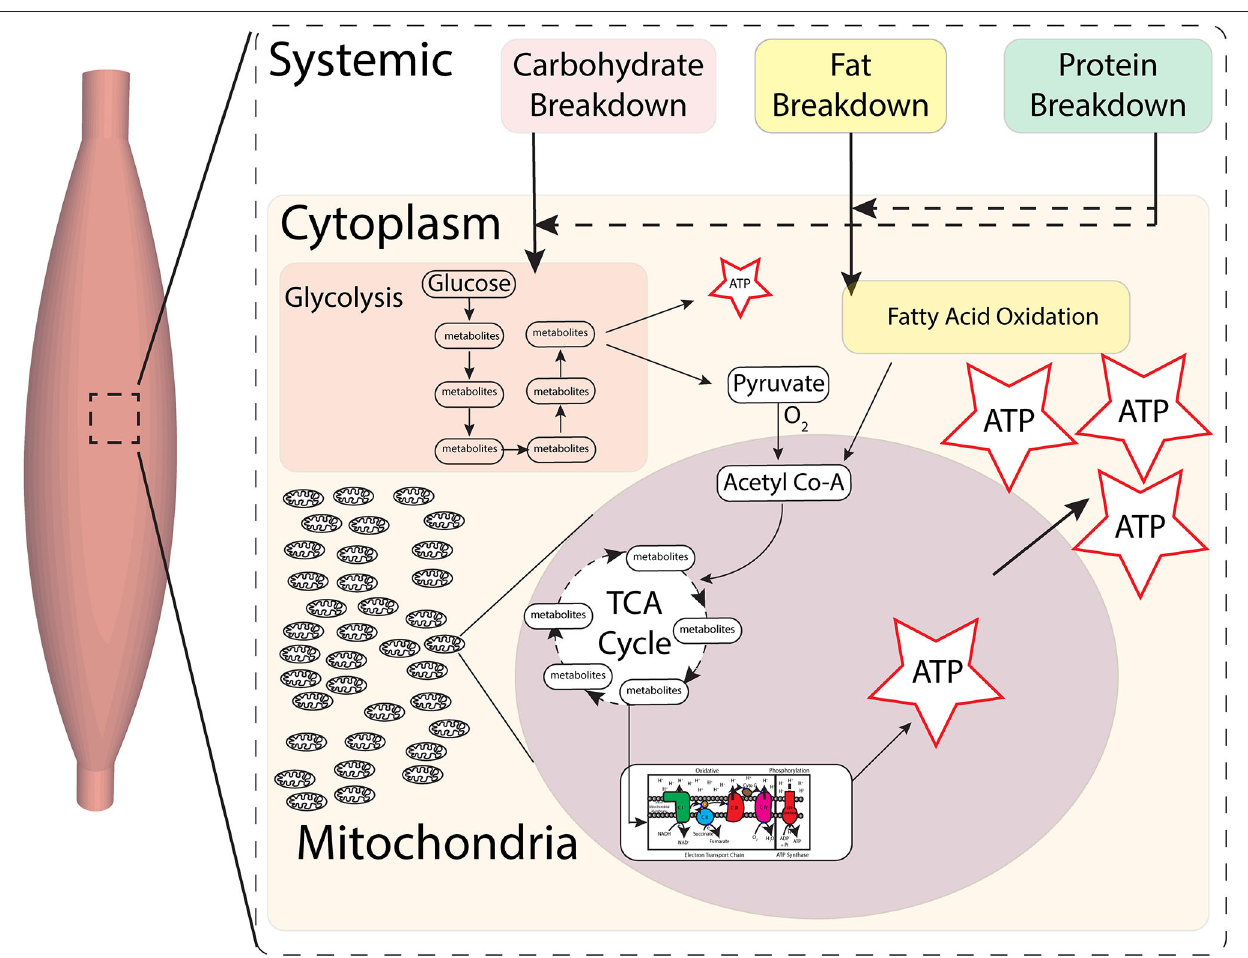
FIGURE 1 | Skeletal muscle metabolic pathways for energy. Carbohydrates, fats, and proteins foods are broken down systemically, substrates of which then enter cells. Production of energy by final breakdown of food occurs primarily within cells by glycolysis and fatty acid oxidation. Anaerobic glycolysis in the cytoplasm can only create small amounts of energy (ATP) in the short term. Substrates from glycolysis then enter mitochondria and, in the presence of oxygen, go through the tricarboxylic acid (TCA) cycle, whose substrates then feed into the electron transport chain (ETC), which in turn is indirectly coupled to ATP synthase to create ATP. Most energy (ATP) production occurs in the presence of oxygen within the mitochondria by breakdown of metabolites via the TCA cycle and oxidative phosphorylation at the ETC-ATP